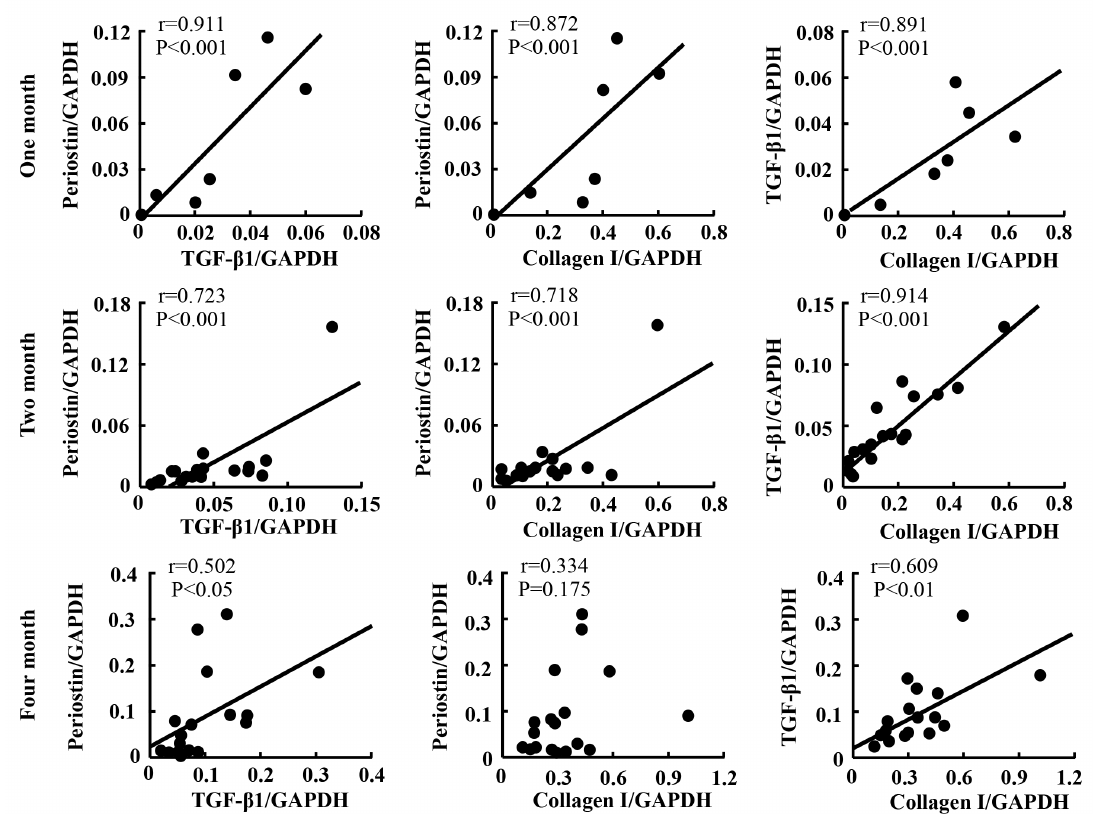
Figure 6. Linear regression analyses of the correlations among the expression levels of periostin, TGF-β1, and collagen I 1, 2, and 4 months after PTFE graft implantation, independent of region.